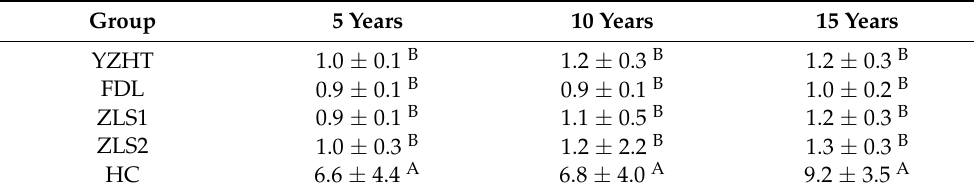
Table 3. Staining surface mean wear (Rz values in µ m) ± standard deviation and grouping according to the material and time (period of